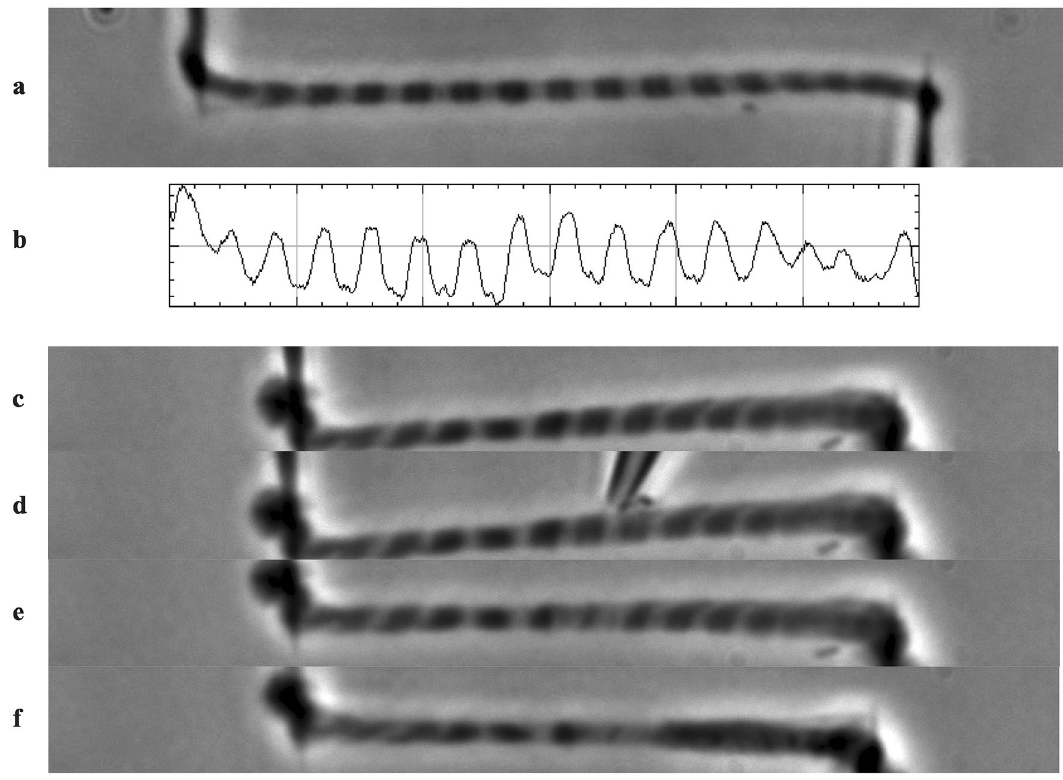
Figure 1. ( a ): An image of a single myofibril suspended between two glass needles and visualized at high magnification. ( b ) Plot profile matching the greyscale pattern of the myofibril in ( a ). The dark A-bands of the sarcomeres produce peaks that are used in the calculation of sarcomere lengths. ( c ) A myofibril with an average sarcomere length of 2.73 μm at rest. ( d ) The tip of the pressure-controlled micro-perfusion system filled with high ionic strength solution is visible above the myofibril. The tip is positioned such that a single sarcomere will be affected by the solution. ( e ) Contractile proteins in a single sarcomere were inactivated by applying high ionic strength solution. Note the reduced appearance of the A-band and more visible Z-lines. ( f ) Myofibril with one inactive sarcomere in a contracted